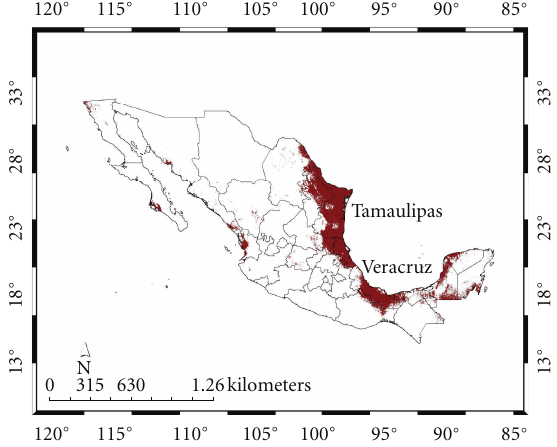
Figure 4: Species distribution model and Mexican states for Ambly- omma cajennense . The principal states are shown (see text).